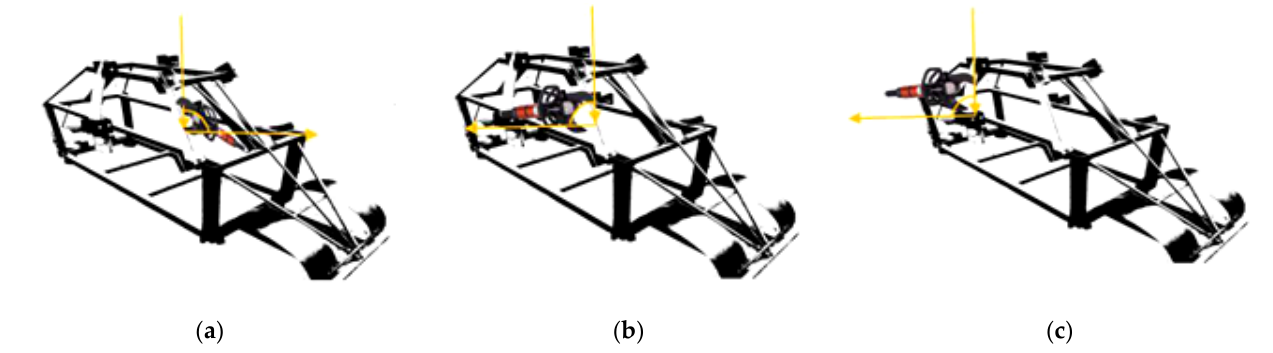
Figure 14. ( a , b ) Type “A” pillar cutting angle; ( c ) type “B” pillar cutting angle.